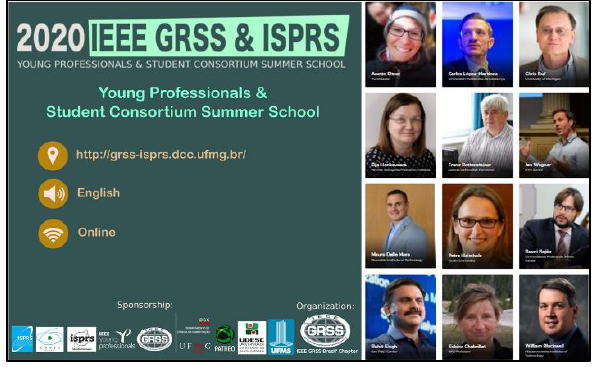
Figure 5 . The speakers for the 6th IEEE GRSS Young Professionals and ISPRS SC Student Consortium Summer School.